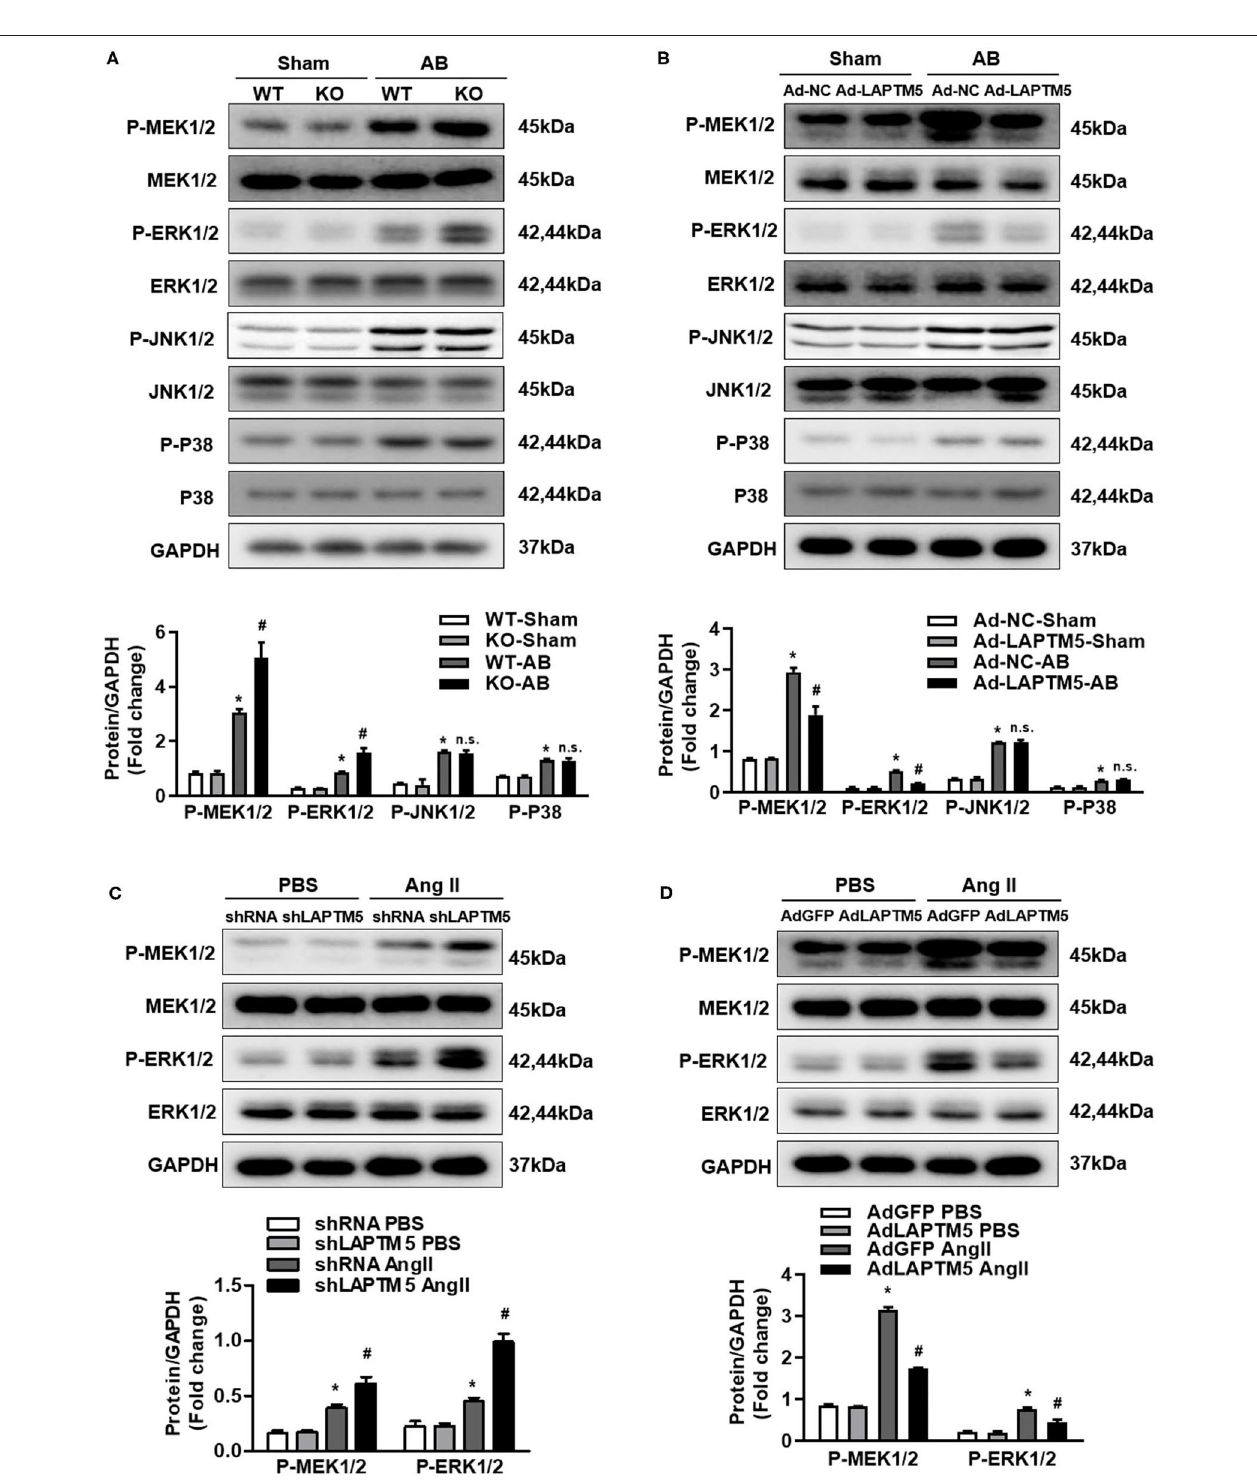
FIGURE 5 | LAPTM5 inhibits the pressure overload-mediated MEK-ERK1/2 signaling pathway. (A) Protein levels of phosphorylated (p-) and total (T-) MEK1/2, ERK1/2, JNK1/2, and P38 in heart tissue in WT and LAPTM5-KO mice ( n = 3) (* P < 0.05 vs. WT-Sham, # P < 0.05 vs. WT-AB). (B) Protein levels of phosphorylated and total MEK1/2, ERK1/2, JNK1/2, and P38 in heart tissue in mice injected with Ad-NC or Ad-LAPTM5 ( n = 3) (* P < 0.05 vs. Ad-NC-Sham, # P < 0.05 vs. Ad-NC-AB). (C) Protein levels of phosphorylated and total MEK1/2 and ERK1/2 in NRCMs transfected with shLAPTM5 ( n = 3) (* P < 0.05 vs. shRNA PBS, # P < 0.05 vs. shRNA Ang II). (D) Protein levels of phosphorylated and total MEK1/2 and ERK1/2 in NRCMs transfected with Flag-LAPTM5 ( n = 3) (* P < 0.05 vs. AdGFP PBS, # P < 0.05 vs. AdGFP Ang II).